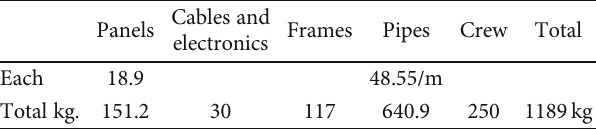
Table 2: Weight budget of the example module. Cables and Panels Frames electronics